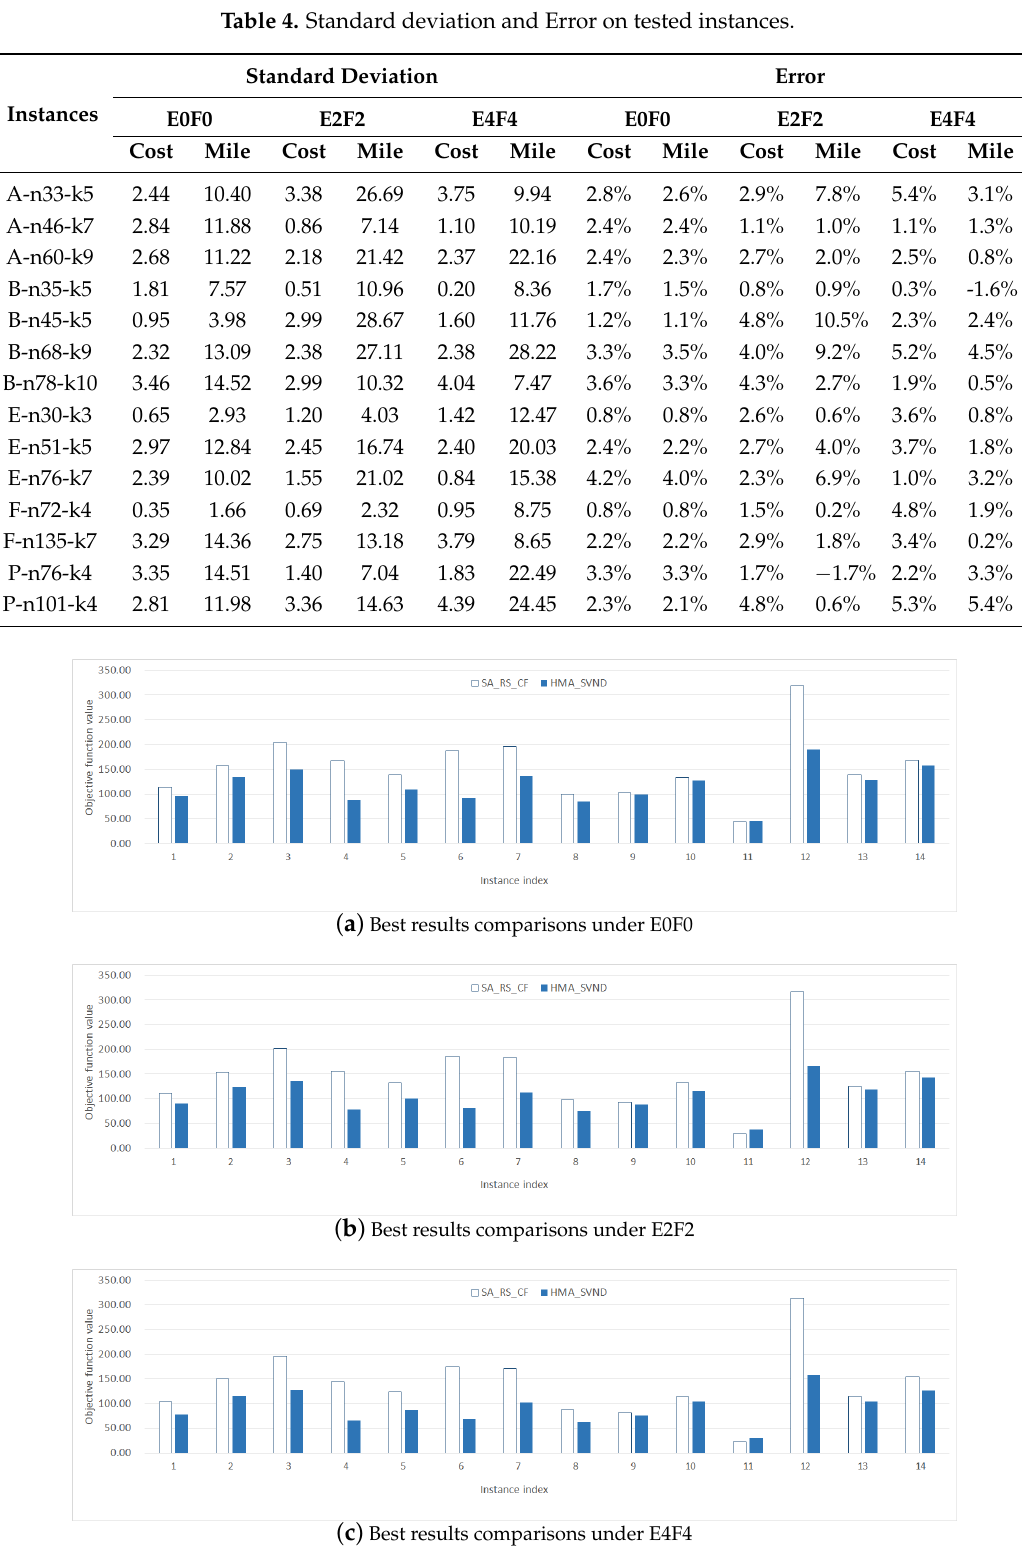
Figure 4. The comparative results of the proposed HMA_SVND method and SA_RS_CF method of Yu et al.